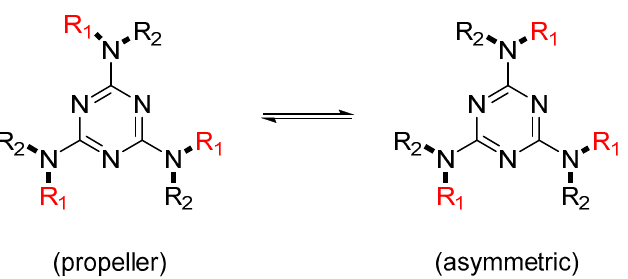
Figure 2. Possible conformers for the 1,3,5-triazine derivatives 4 , 5 , 6 , 11 , 12 , 13 and 14 . Substituents R 1 and R 2 are presented in Table 2.